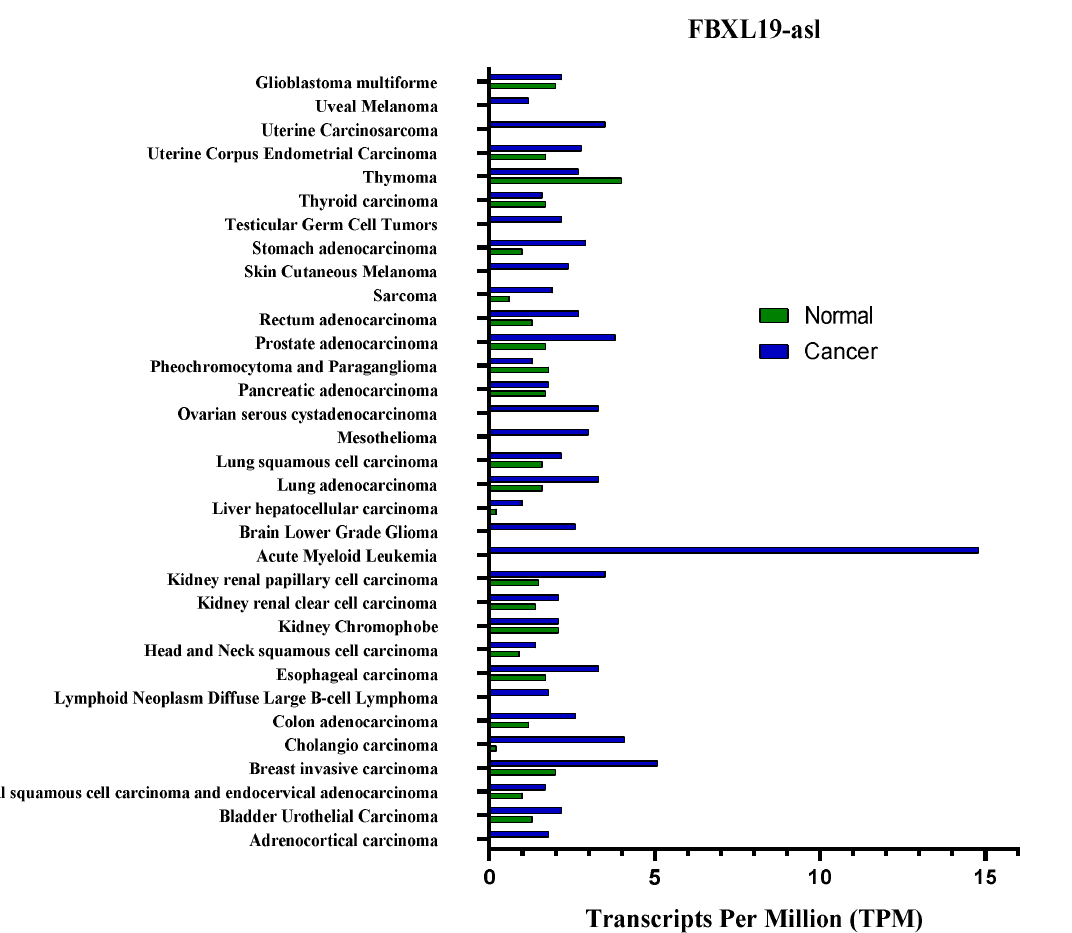
Figure 4. The gene expression of FBXL19-AS1 profile across all tumor samples and paired normal tissues.